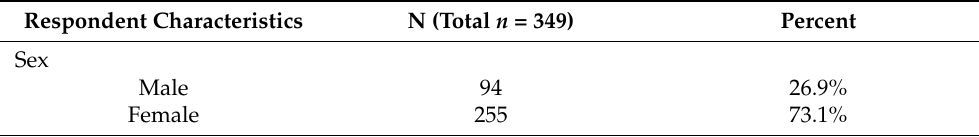
Table 2. Respondents’ demographic